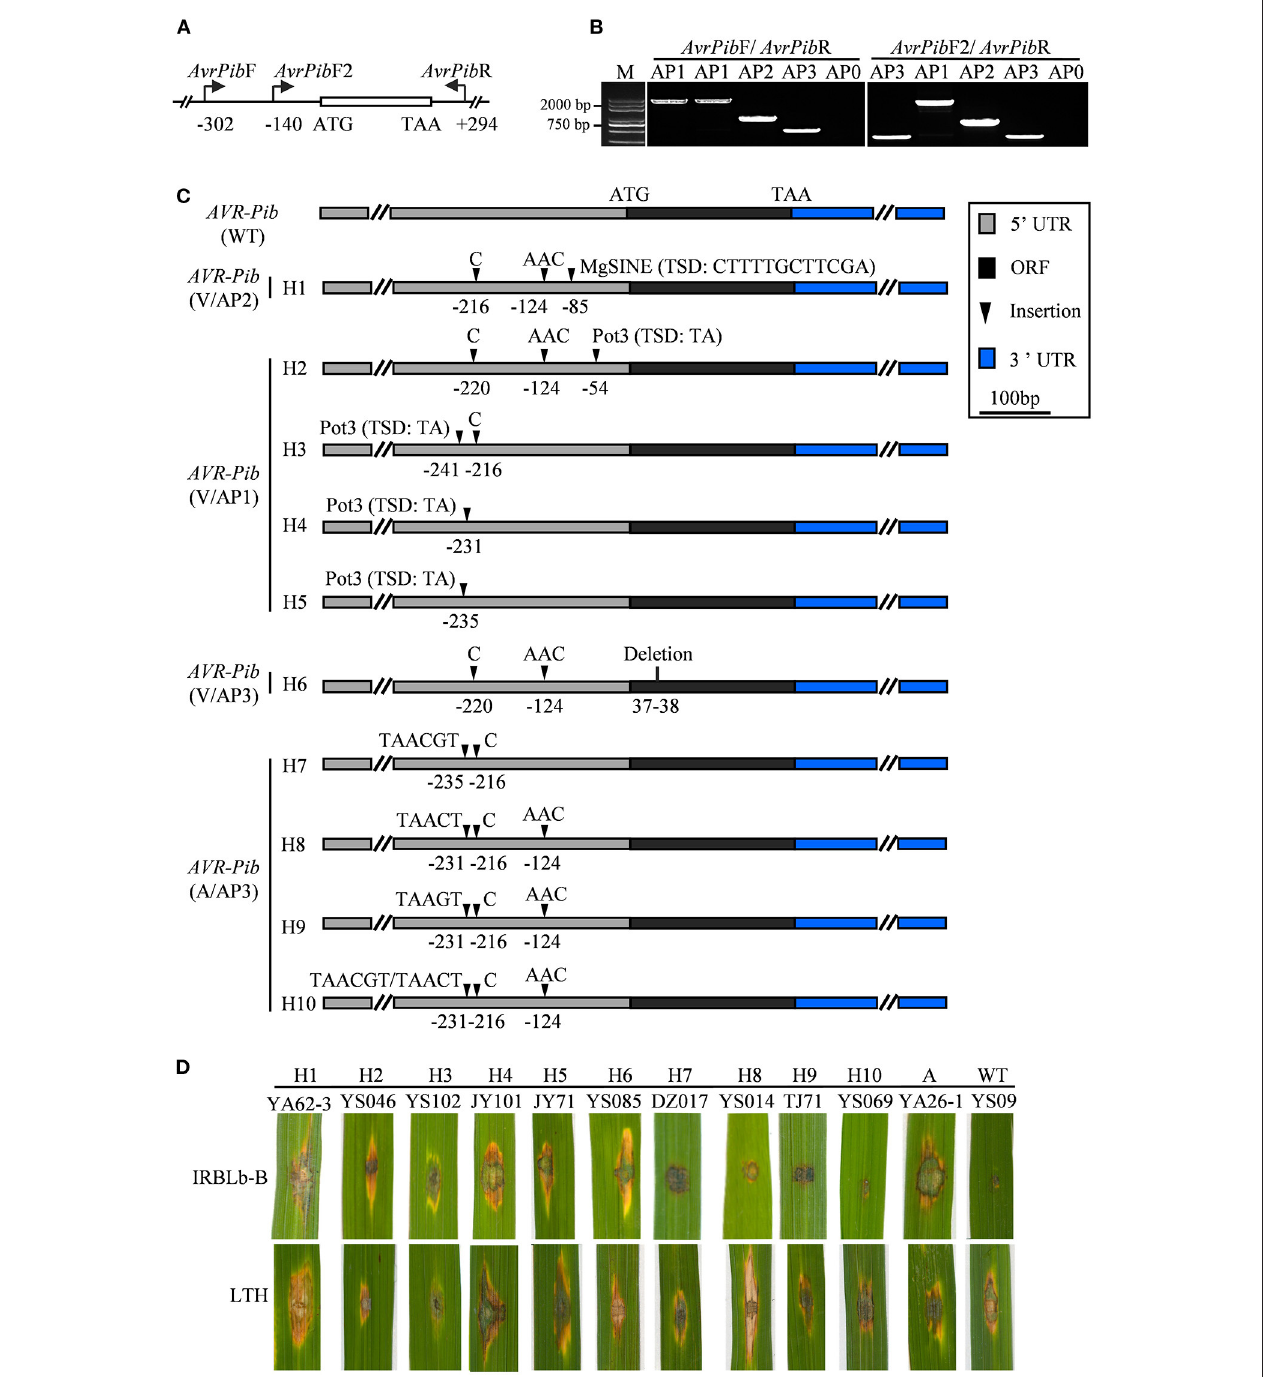
FIGURE 3 | AVR-Pib variants and their pathogenicity to IRBLb-B. (A) Graph illustrates the location of the primer pairs AvrPibF / AvrPibR and AvrPibF2 / AvrPibR used to examine the variation in AVR-Pib locus. (B) Amplification patterns of AVR-Pib . Four amplification patterns (AP0-AP3) were classified by the size of the fragments, which amplified from different isolates by indicated primers. AP0 indicates no amplicon. AP1, AP2, and AP3 indicate different sizes of amplicons. M, marker. (C) Characterization of allelic variations at AVR-Pib . H1 to H10, ten haplotypes of AVR-Pib contain different variations. (D) Pathogenicity of the indicated isolates on the monogenic line IRBLb-B carrying Pib . A, absence of AVR-Pib in the indicated strain.